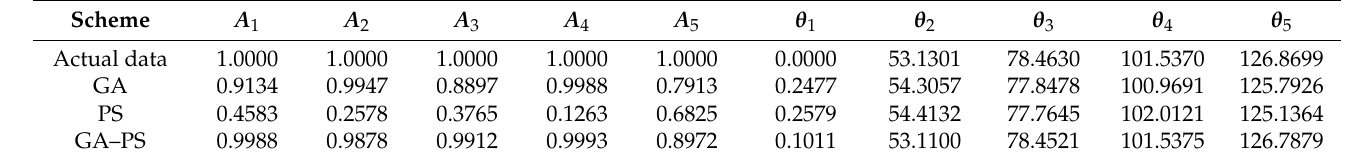
Table 6. Comparison of DOAs achieved using GA, PS, and